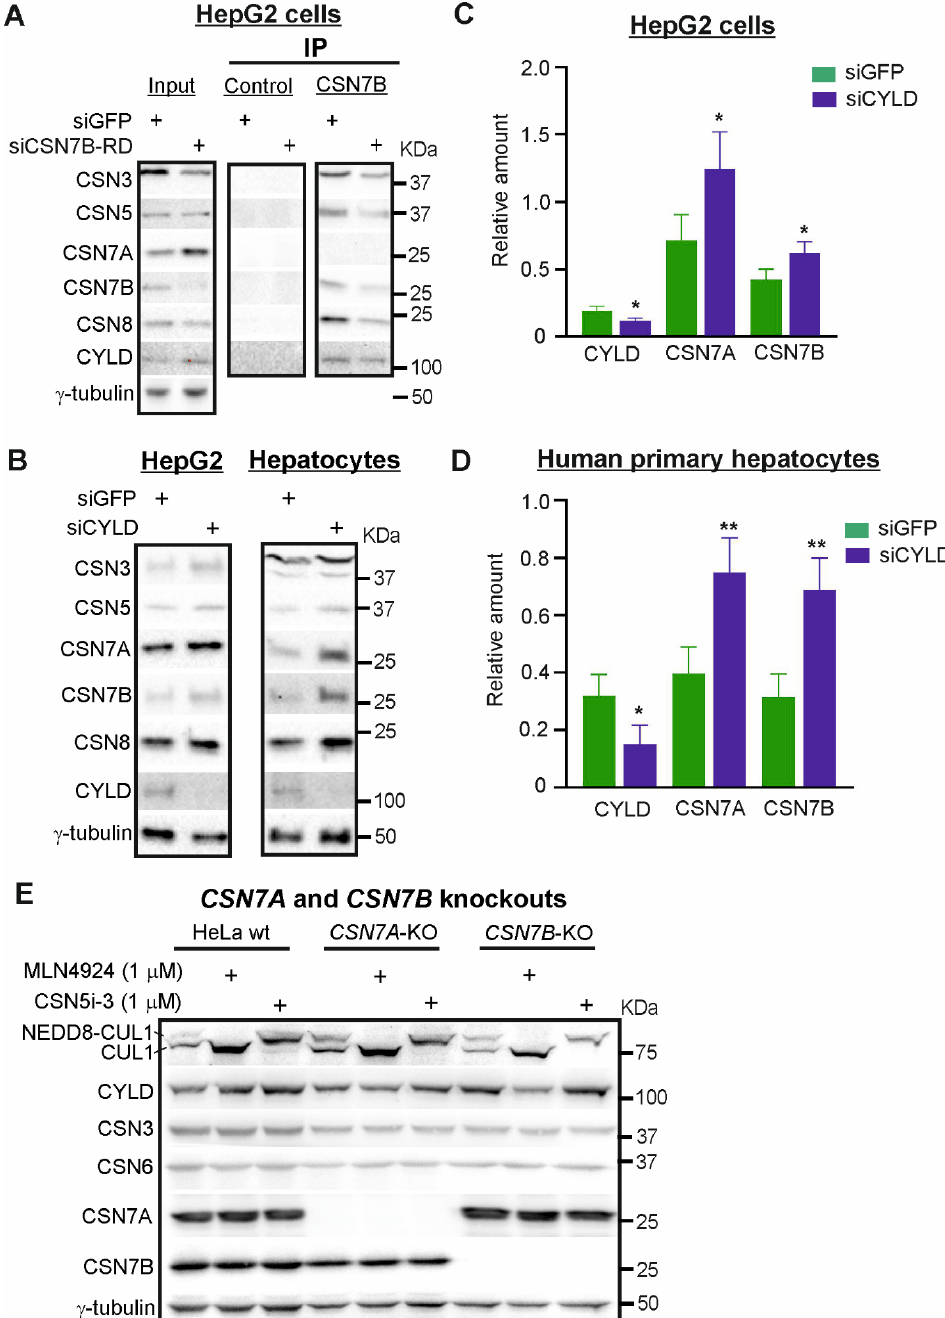
Figure 4. Silencing of CYLD stabilizes CSN7A as well as CSN7B in HepG2 cells and in human primary hepatocytes. ( A ) Immunoprecipitation of CSN7B. Western blot of HepG2 cells transfected with siGFP or siCSN7B-RD for 48 h (input, left panel) and IP of CSN7B (middle and right panel). Antibodies were used as indicated. ( B ) Western blot of HepG2 cells (left panel) or human primary hepatocytes (right panel) transiently transfected with siGFP or siCYLD for 48 h. Antibodies were used as in ( A ). ( C , D ) Western blots as shown in ( B ) left panel, ( C ) or in ( B ) right panel, ( D ) were quantified by densitometry to measure the abundance of CYLD, CSN7A and CSN7B after transfection with siGFP (control) or siCYLD. Data were normalized to γ -tubulin and expressed as means of relative amounts plus/minus standard deviations (SD, n = 4). Unpaired Student’s t -test was used for statistical analysis. * p < 0.05, ** p < 0.01. ( E ) Western blots of HeLa wildtype (wt), HeLa- CSN7A -KO and HeLa- CSN7B -KO cells treated without or with MLN4924 (1 µ M) or CSN5i-3 (1 µ M) for 16 h. Antibodies were used as